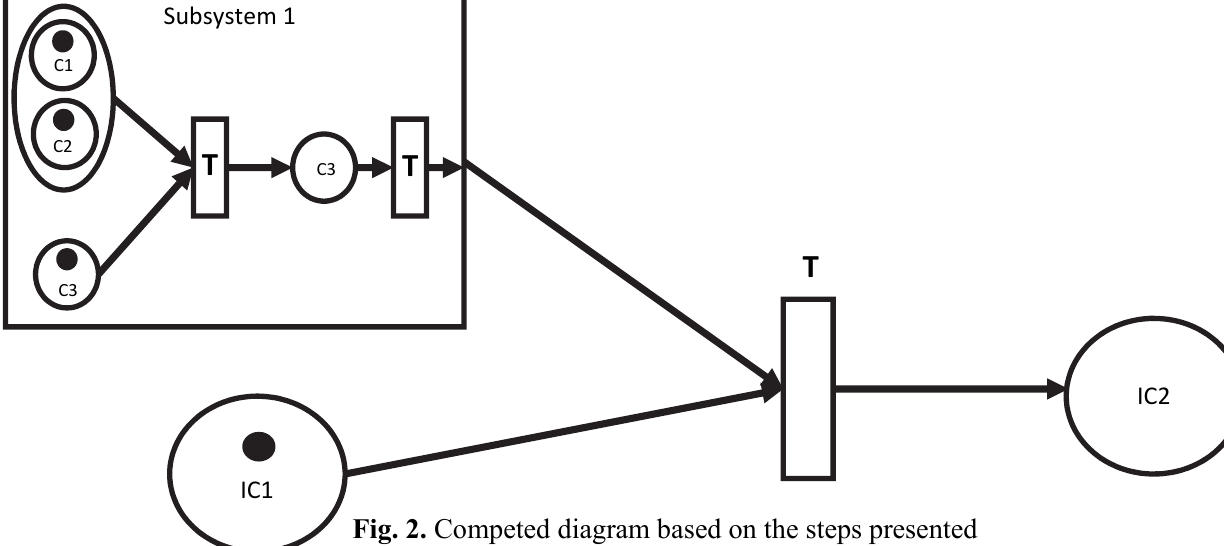
Fig. 2. Competed diagram based on the steps